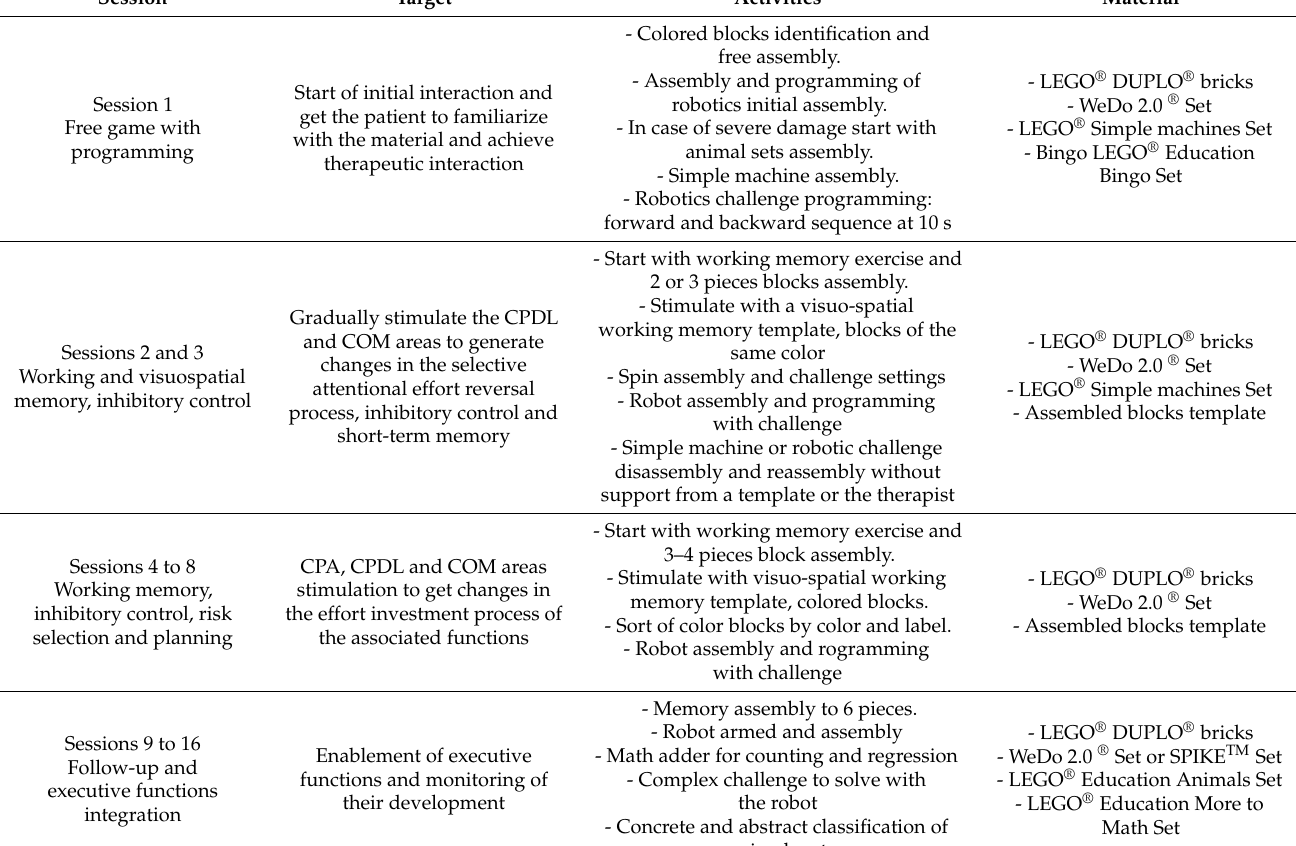
Table 1. Intervention of Executive Functions with LEGO ® -based therapy (also see Appendix